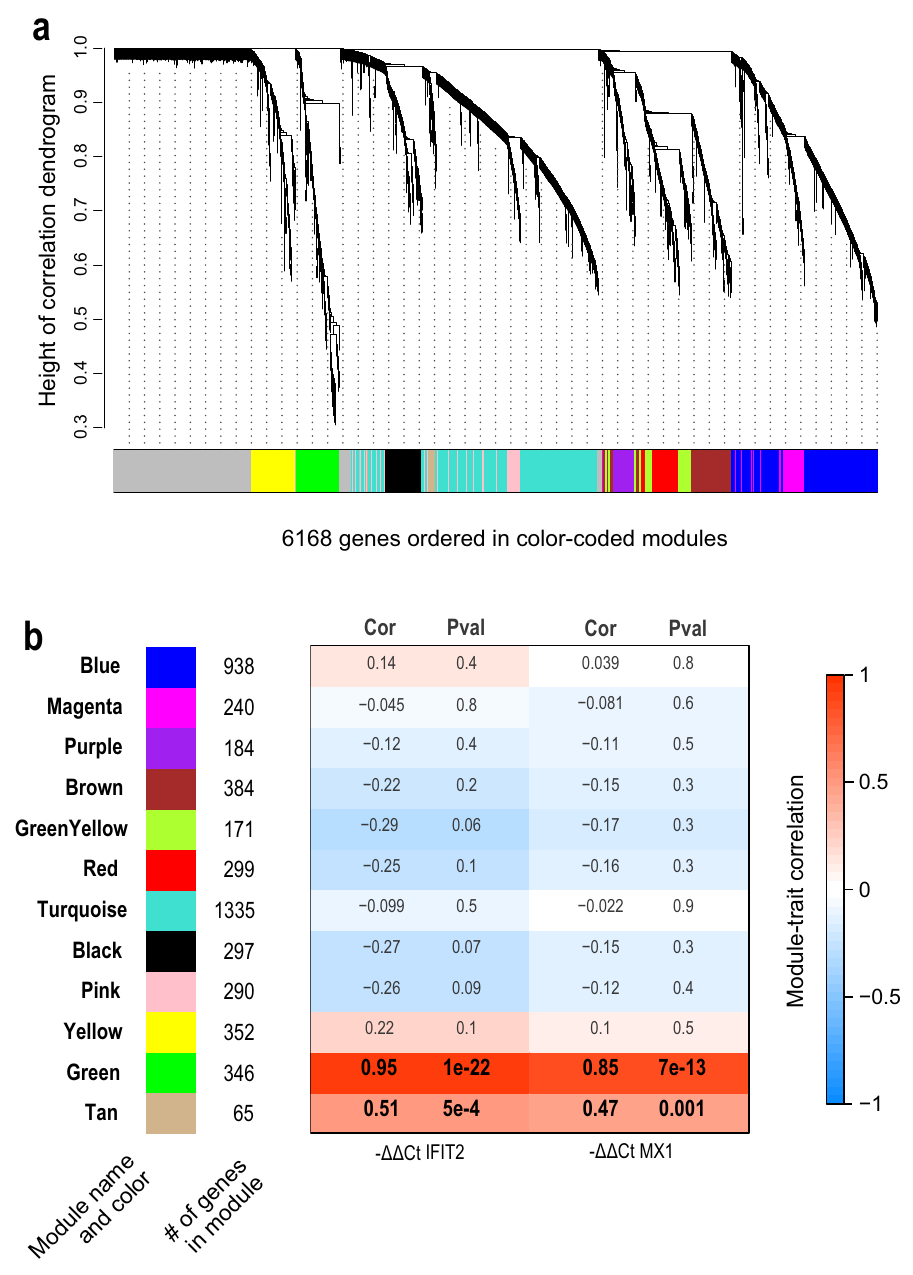
Figure 2. Generation of the gene co-expression network and selection of modules associated with IFN treatment. ( a ) Gene dendrogram generated on the Topological Overlap Dissimilarity matrix: each branch of the dendrogram corresponds to a module of highly interconnected genes, for a total of 12 modules identified. The color row below the dendrogram represents the module assignment. ( b ) Identified modules with relative colour “names”: numbers beside each colour block indicates the number of genes assigned to each of them. The heat map shows the correlation values (Pearson correlation degree “Cor” and statistical significance “Pval”) between each module eigengene and the induction of IFIT2 and MX1 transcripts measured by real-time PCR. Negative correlations are in blue, positive correlations are in red. Only Green and Tan modules show a significant positive correlation with the ISGs